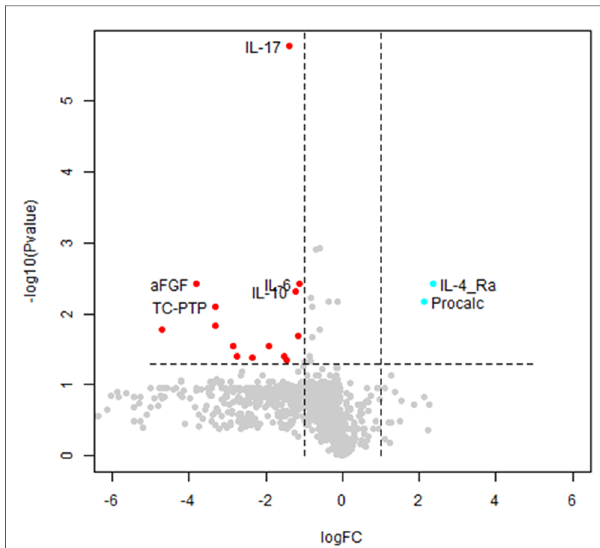
FIGURE 3 Volcano plot of autism spectrum disorder (ASD) cases vs. typically developing (TD) controls. A volcano plot of the t -test differences between ASD and TD children. Each dot represents a marker. Markers signi fi cantly downregulated in ASD with a change of 2-fold or more are shown in red. Signi fi cantly altered markers increased 2-fold or more in ASD are shown in cyan. Markers chosen to be included in any MLR model are labelled. FC, fold change; Procalc, procalcitonin.